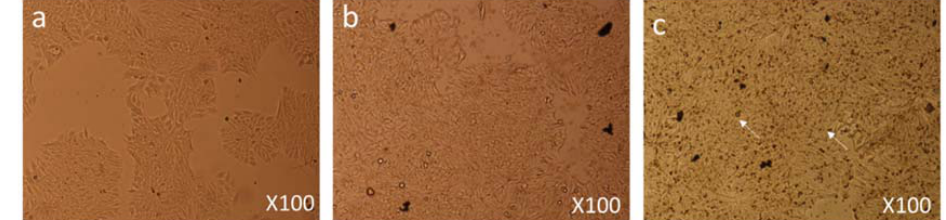
Figure 5. Cell Morphology: The MCF ‐ 7 cells showing morphology ( a ) control (non ‐ treated), ( b ) treated with FMSP ‐ nanoparticles (12.5 μ g/mL) for 6 h, ( c ) treated with FMSP ‐ nanoparticles (12.5 μ g/mL) for 24 h. FMSP ‐ nanoparticles ‐ treated cells showing cell death (arrows) after 24 h of post ‐ FMSP ‐ nanoparticle treatment. 100× magnification.